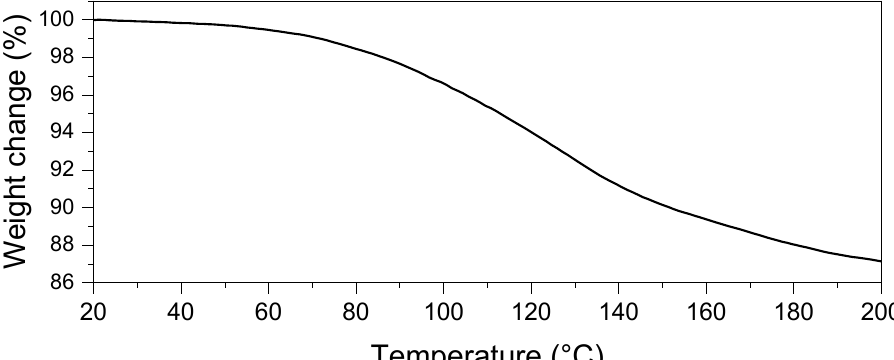
Figure 4. TG profile of CaHS under inert atmosphere (120 mL/min N 2 ) while heating the CaHS from Figure 3. FTIR spectra of Na 2 HS and CaHS. r.T. to 200 °C.